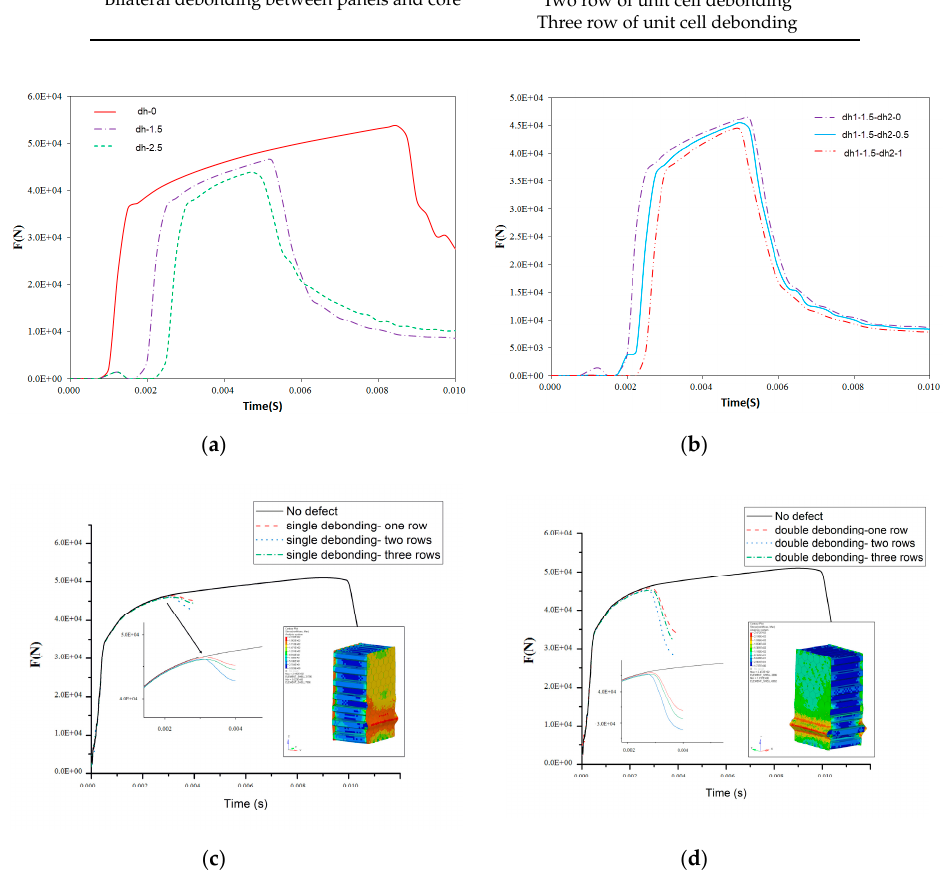
Figure 10. ( a ) Force-time curve with panel unilateral uneven height; ( b ) Force-time curve with panel bilateral uneven height; ( c ) Force-time curve with unilateral debonding; ( d ) Force-time curve with bilateral debonding.